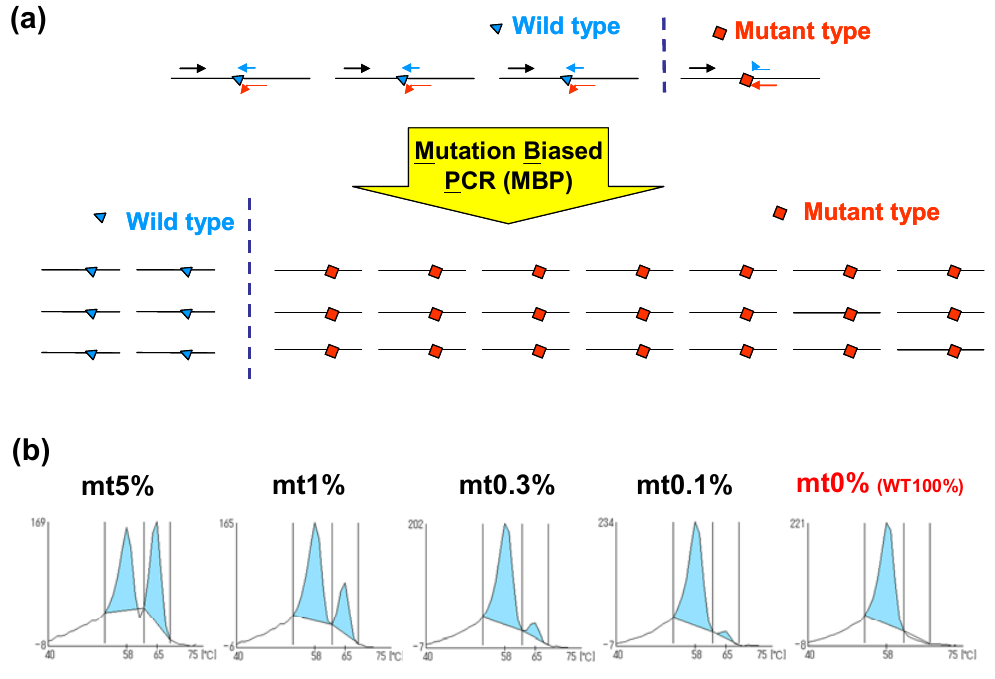
Figure 2. Measurement principle—Mutation biased PCR (MBP). ( a ) The primers for wild and mutant types are mixed with plasmid DNA, which leads to high specificity because each primer can be competitively hybridized to wild type and mutant type sequences. In addition, the length of primer for mutant type is longer than that for wild type,